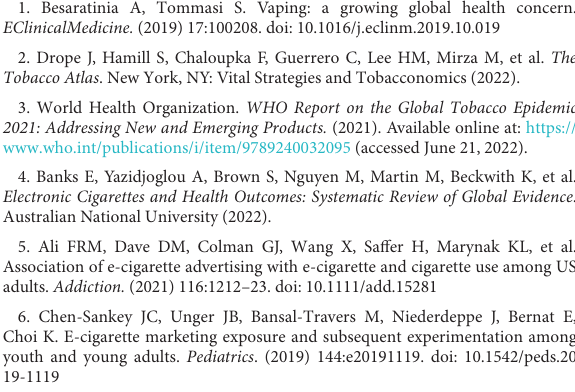
SUPPLEMENTARYIMAGE3 Examples of different types of flavors used to market e-cigarettes. SUPPLEMENTARYFIGURE1 Volume and proportion of tobacco marketing by product type in India, Indonesia, and Mexico. SUPPLEMENTARYFIGURE2 Percentage of e-cigarette marketing by account type in India, Indonesia, and Mexico. SUPPLEMENTARYFIGURE3 (A–C) Avenues for purchase of e-cigarettes promoted in Instagram posts in India, Indonesia, and Mexico. SUPPLEMENTARYFIGURE4 Marketing tactics used to promote e-cigarettes in India, Indonesia and Mexico. SUPPLEMENTARYFIGURE5 (A) E-cigarette product brands with known parent companies marketed in India, Indonesia, and Mexico. (B) Origin of parent companies of e-cigarette product brands with known parent companies marketed in India, Indonesia, and Mexico. SUPPLEMENTARYFIGURE6 (A,C) Percentage of e-cigarette marketing by social media platforms in India, Indonesia, and Mexico. (B) Total engagement and average engagement by platform in India, Indonesia, and Mexico. SUPPLEMENTARYFIGURE7 (A) Volume of e-cigarette marketing by message framing in India, Indonesia, and Mexico. (B) Total engagement and average engagement by message framing in India, Indonesia, and